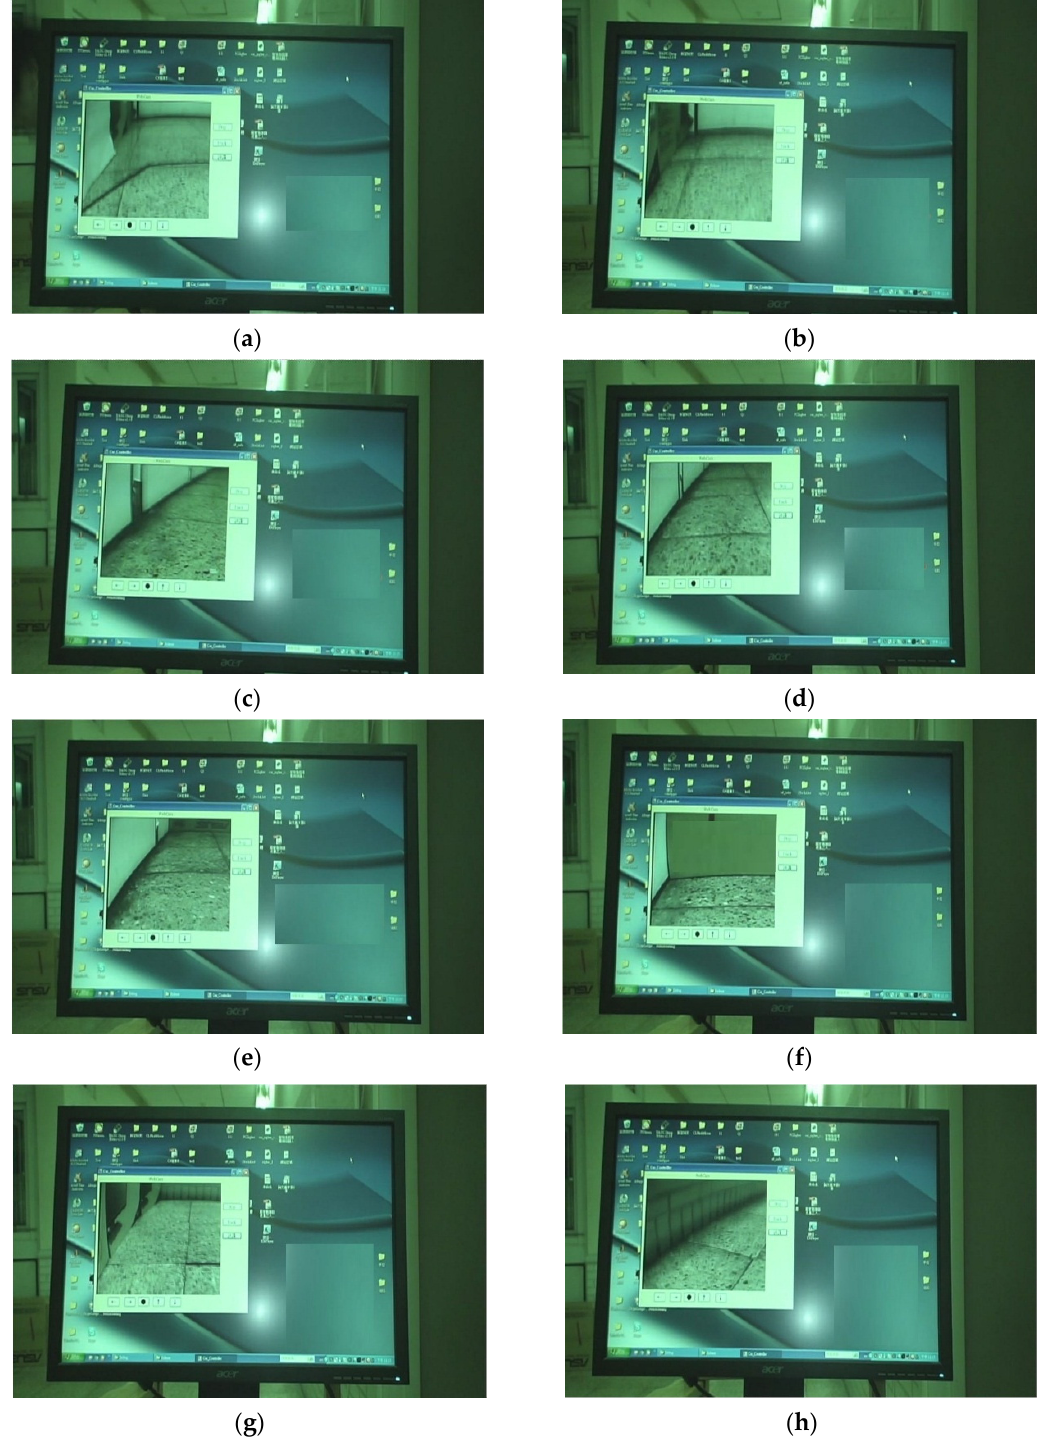
Figure 28. Initial position in the remote surveillance testing field. ( a ) ( b )